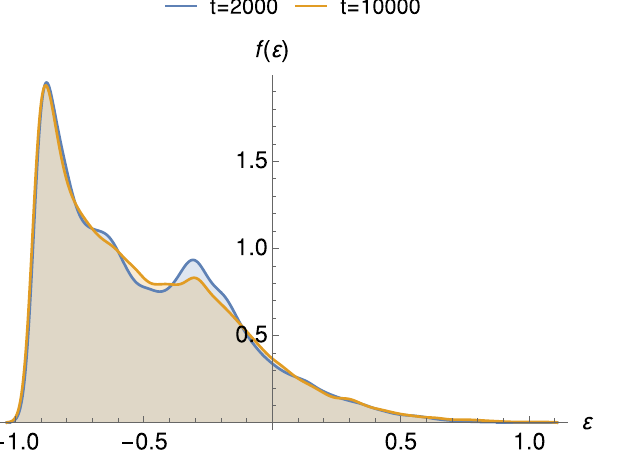
Figure 4. Two histograms representing the energy distribution of particles computed from a symplectic integration with N = 2.5 × 10 4 particles. The energy distributions have been obtained from averaging over the data obtained in 40 equidistant instants in a time range of 80 time units about the times t = 2000 and t = 10 4 .